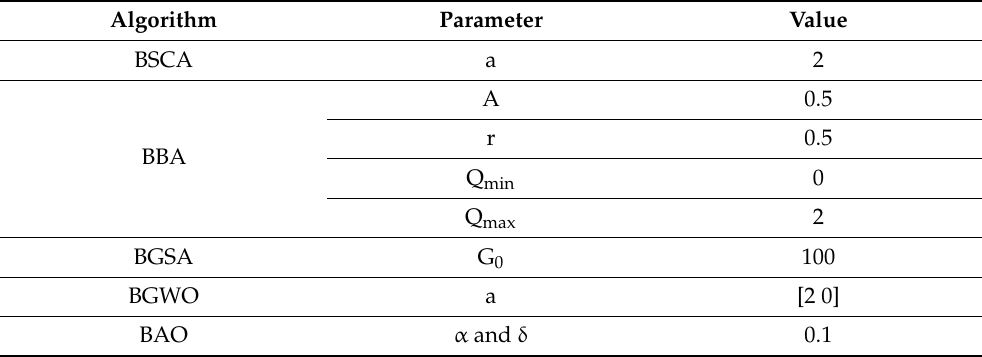
Table 3. Algorithms parameter settings.